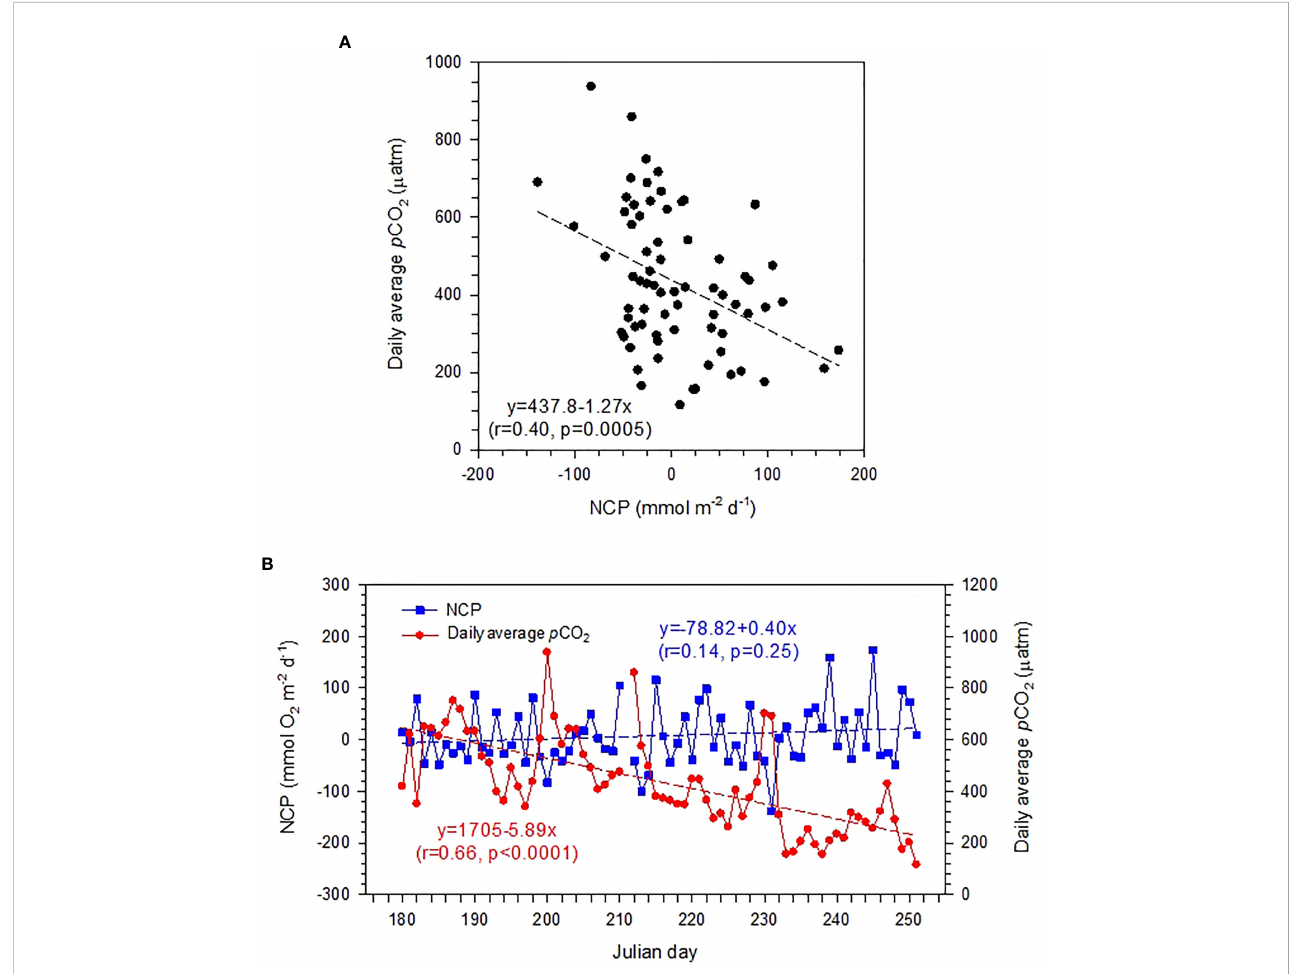
FIGURE 6 (A) The relationship between daily average p CO 2 and net community production (NCP), and (B) daily variations in NCP and average p CO 2 during the study period (June 29 to September 9, 2019, Julian day 180 –